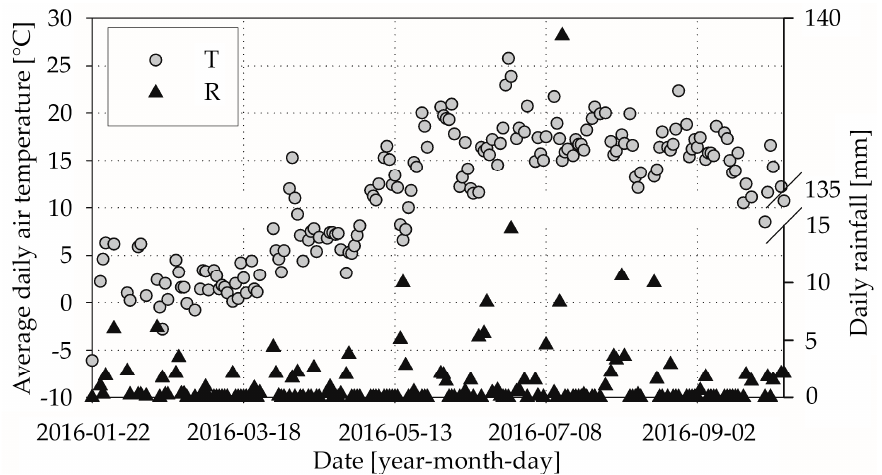
Figure 1. Average daily air temperature and daily rainfall in the investigated period.